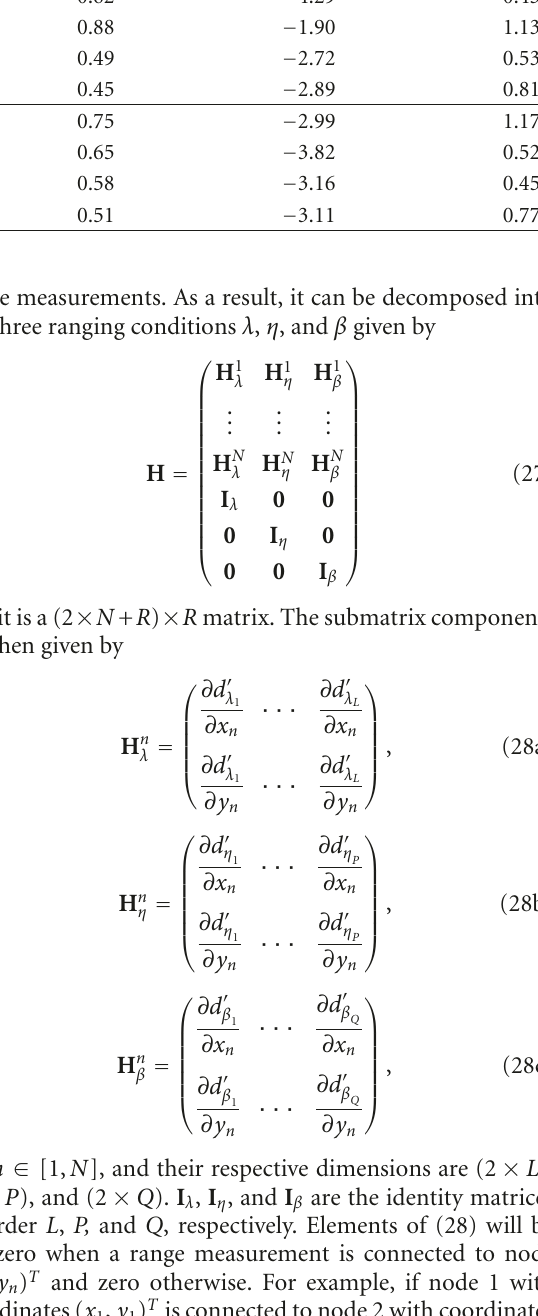
Table 4: Lognormal distribution modeling parameters of the normalized ranging error. Subscripts denote the source of the ranging error. Scenario Environment